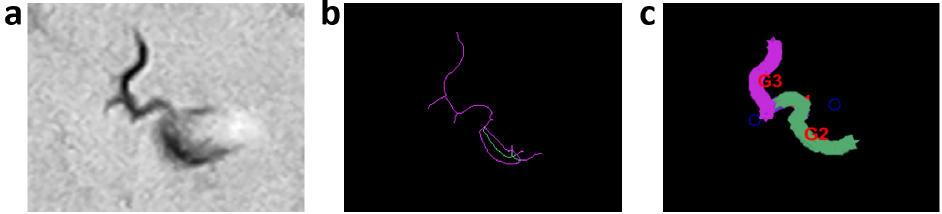
Figure A10. Model 7 evaluation, example 4. Errors occurred by the presence of noise. ( a ) Grayscale image. ( b ) Resulting skeleton using the improved form of skeletonizing. ( c ) Optimization result.